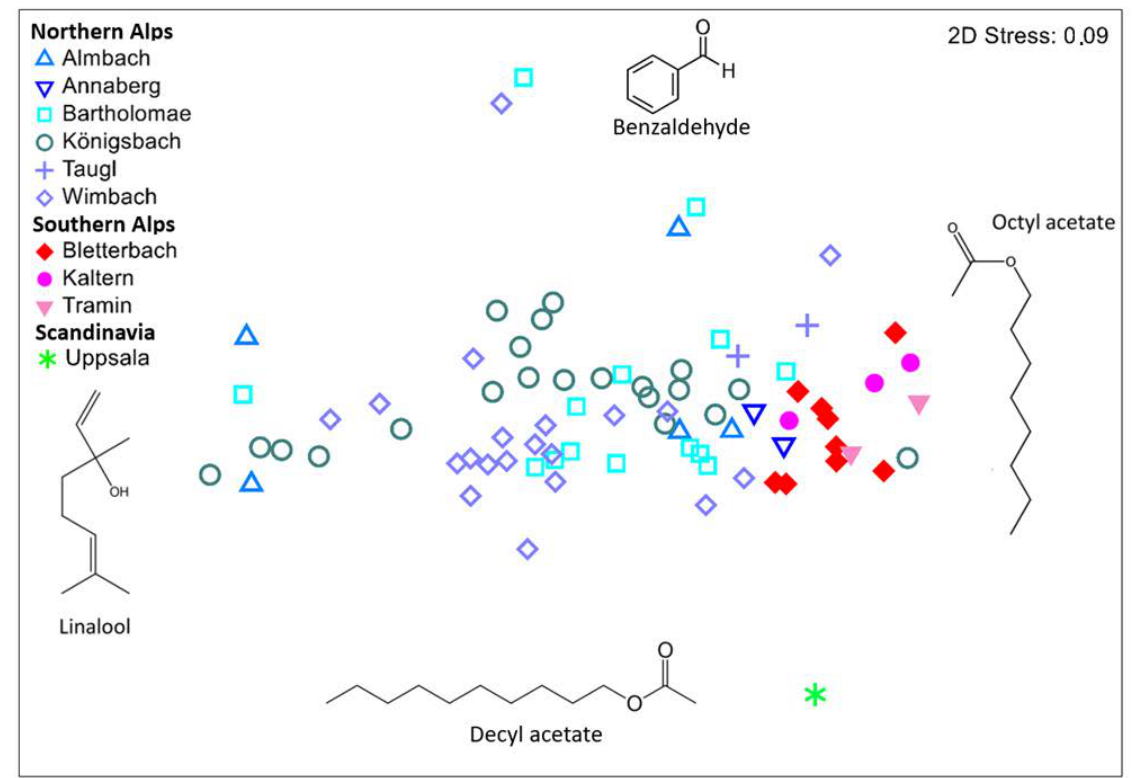
Figure 3. Non-metric multidimensional scaling (NMDS) were used to visualize semi-quantitative similarities among the single scent samples collected from overall ten different populations in the Southern and Northern Alps, and in Uppsala, Scandinavia. All dots represent single scent samples, with the exception of the Uppsala-data point, which represents the mean of three samples (see Methods). This ordination is based on pairwise Bray–Curtis similarities. Compounds most responsible for ordination of samples as indicated by a SIMPER analysis are also plotted. Data from the Northern Alps (except populations Annaberg and Taugl) were from Braunschmid et al. [12], those from Uppsala, Scandinavia from Bergström et al. [18], and all others were collected for the present